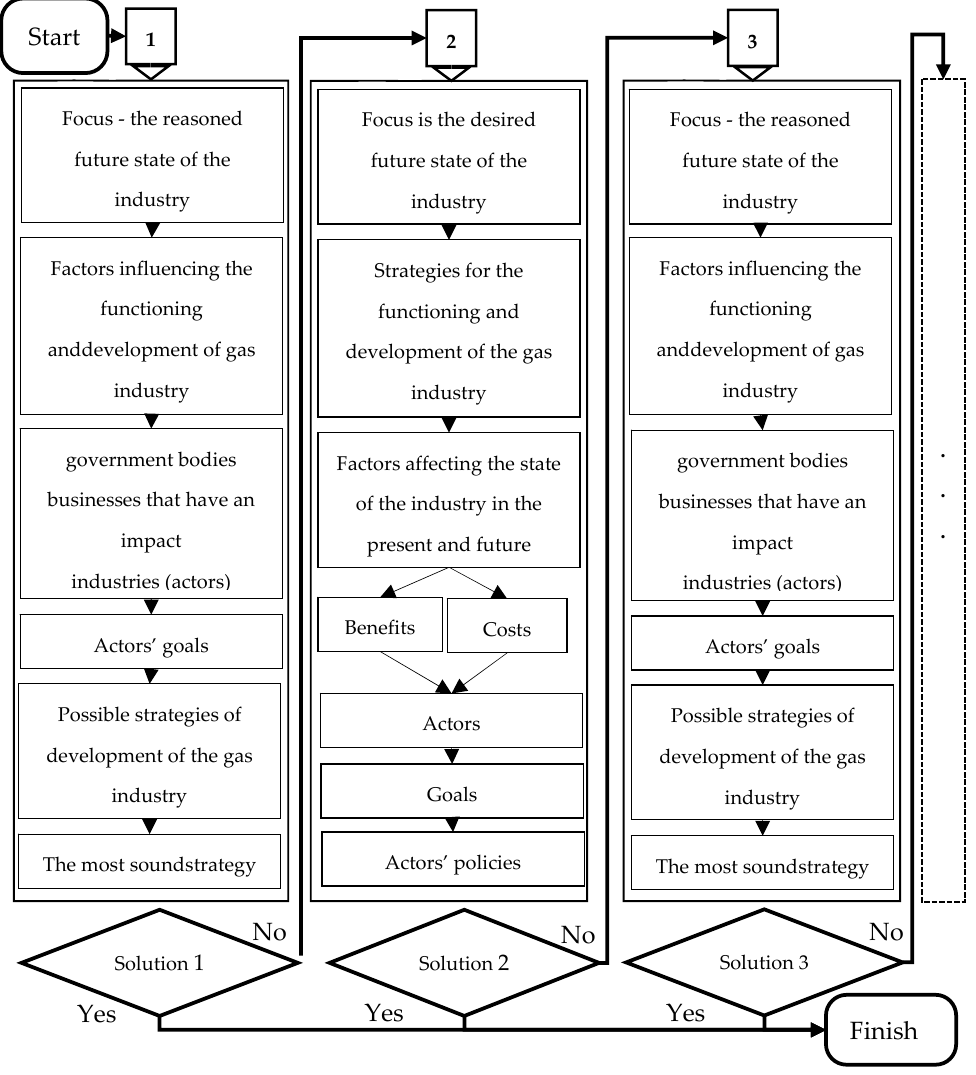
Figure 1. Algorithm for iterative strategic planning processes for the development of the gas in ‐ dustry.